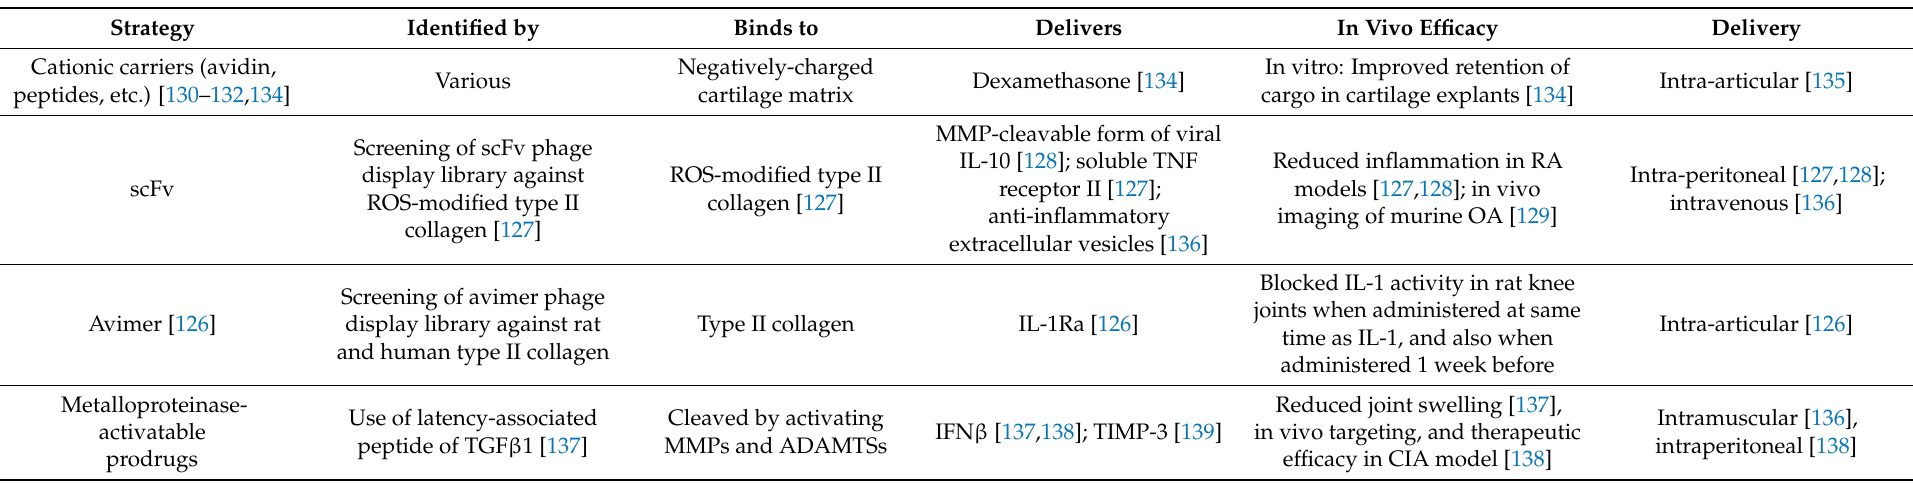
Table 2. Examples of scaffolds used for targeting of potential OA therapies to